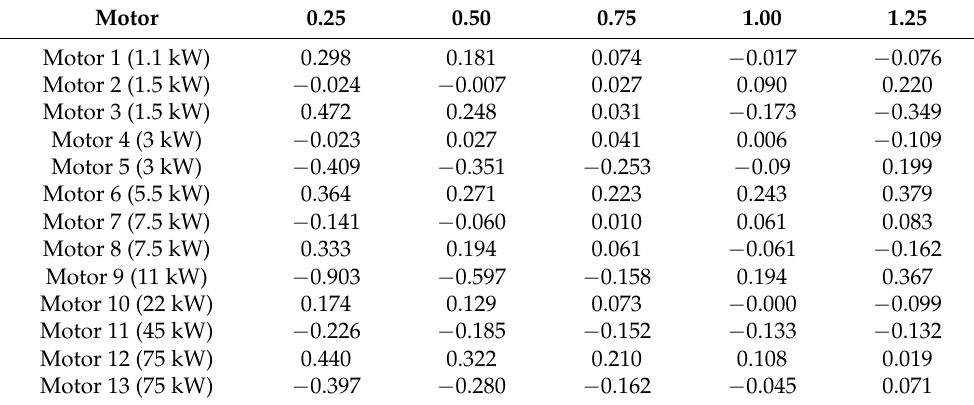
Table 1. The error vs. motor mechanical power (in p.u.).